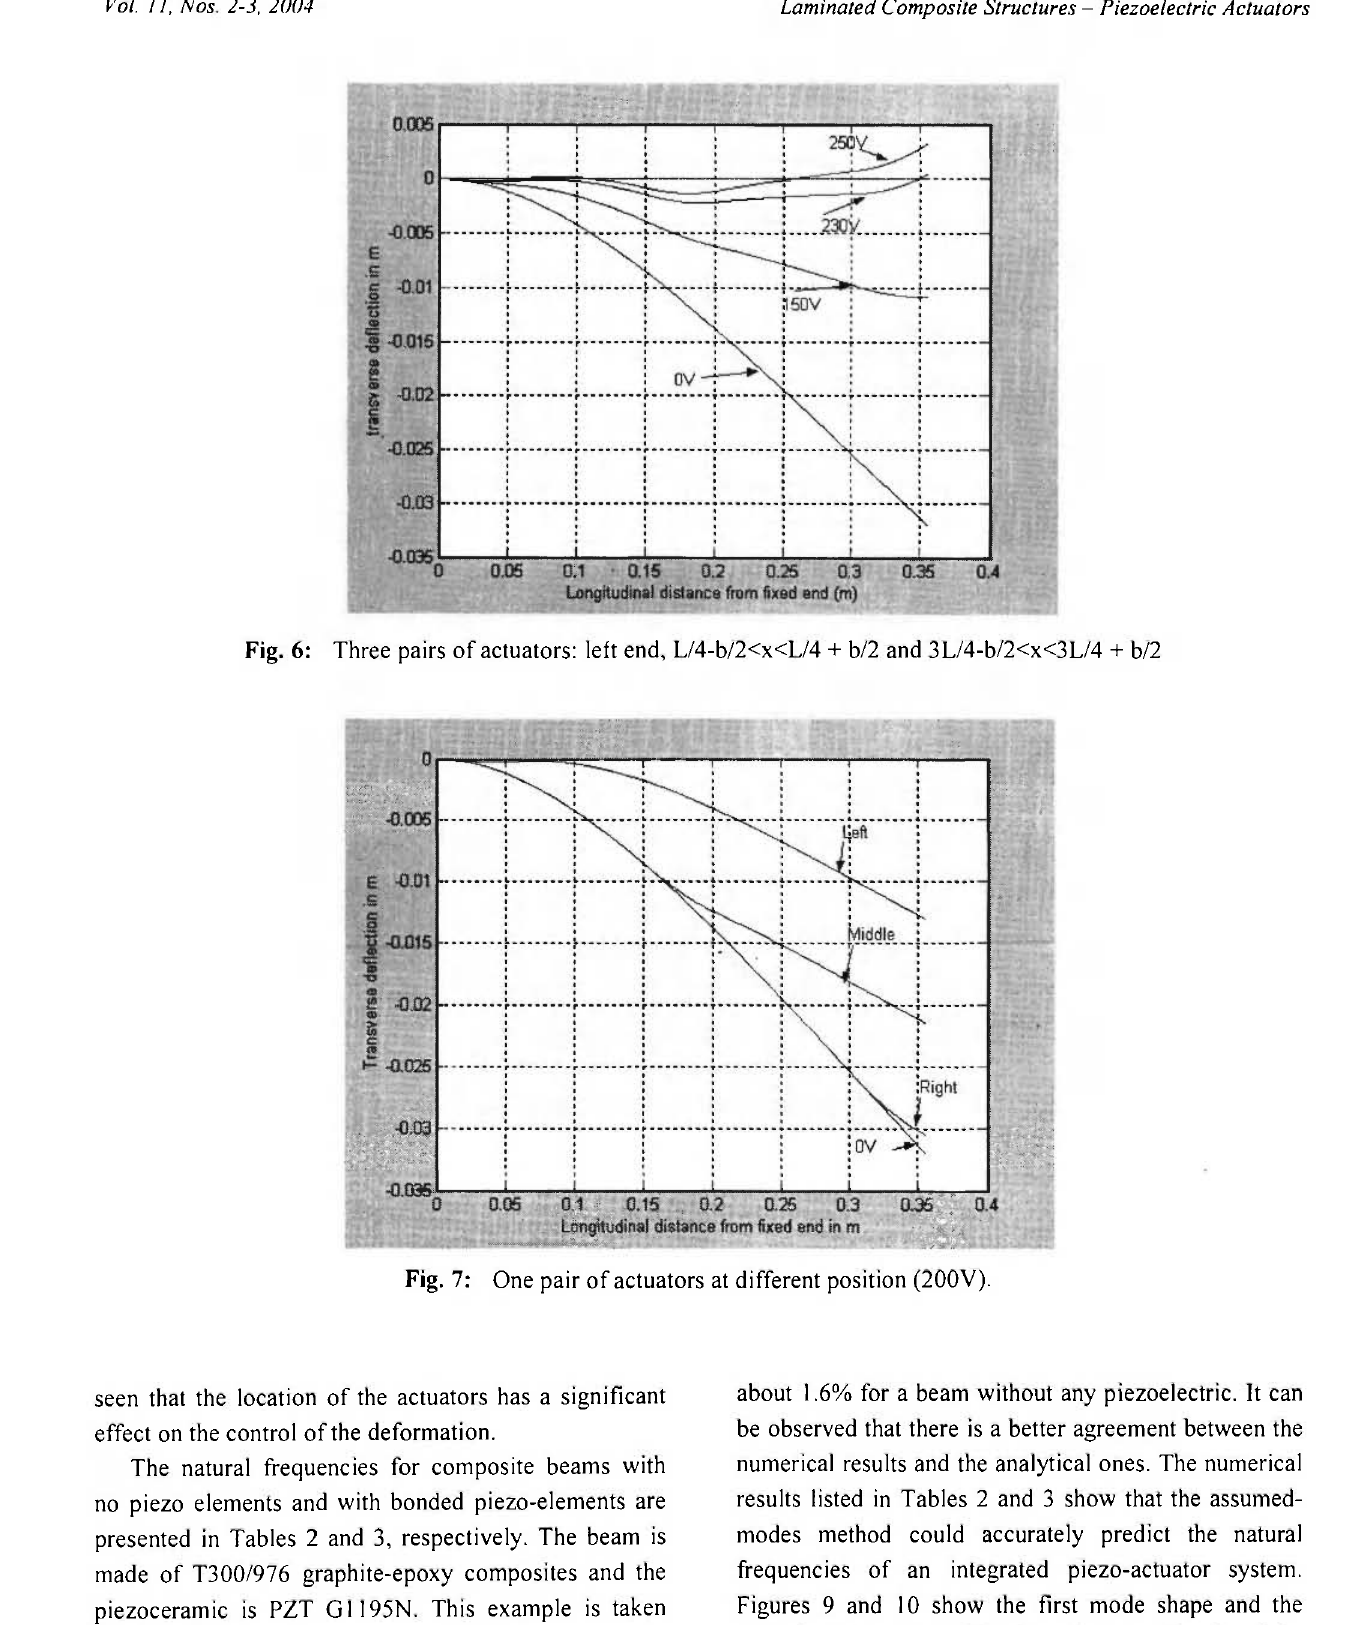
Fig. 7: One pair of actuators at different position